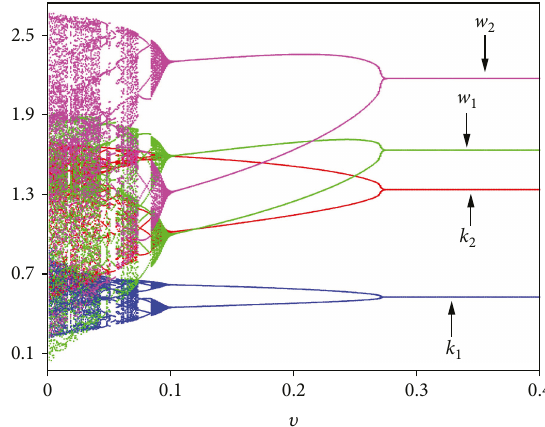
Figure 22: Bifurcation diagram when υ varies from 0 to 0.3 and μ = 0 892 .